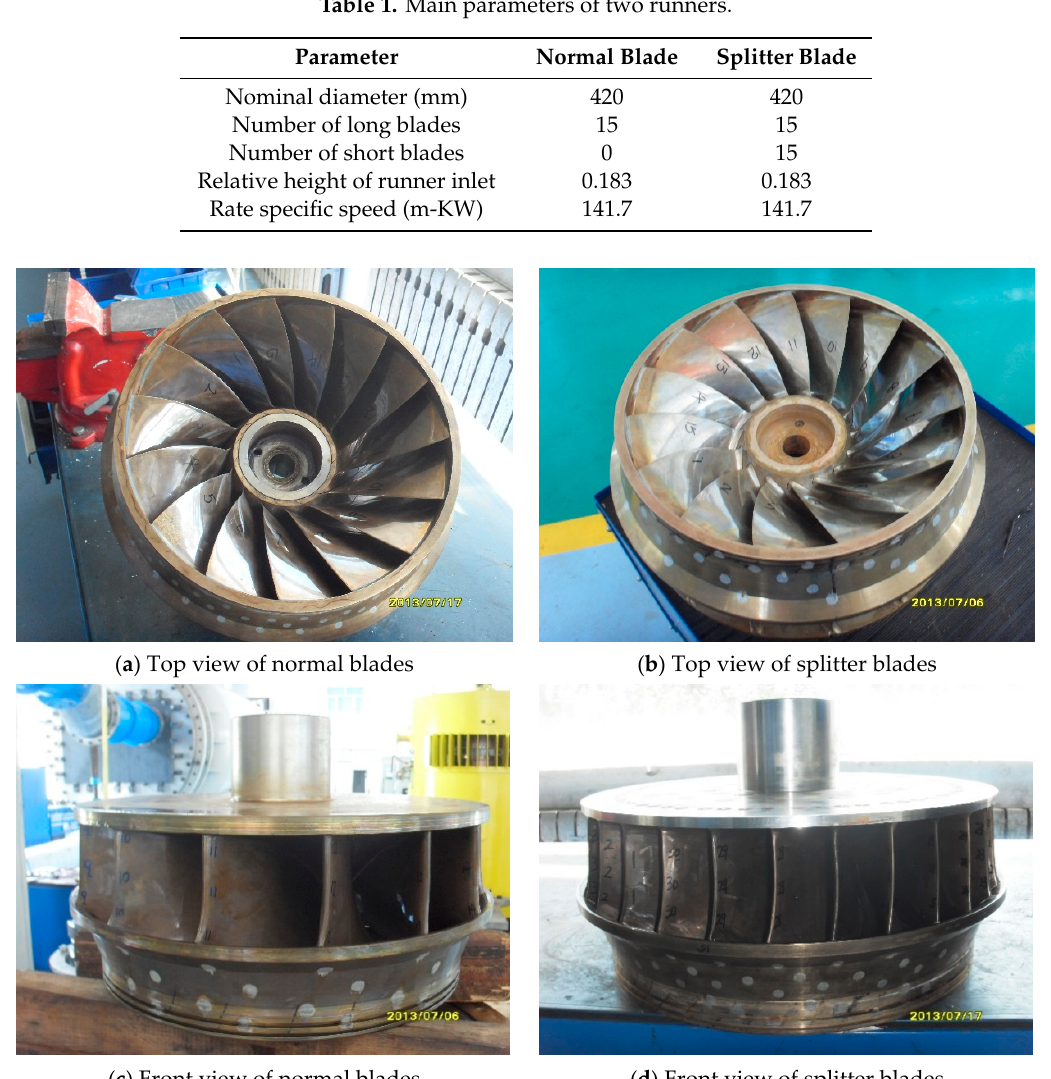
Figure 2. Two types of runners.